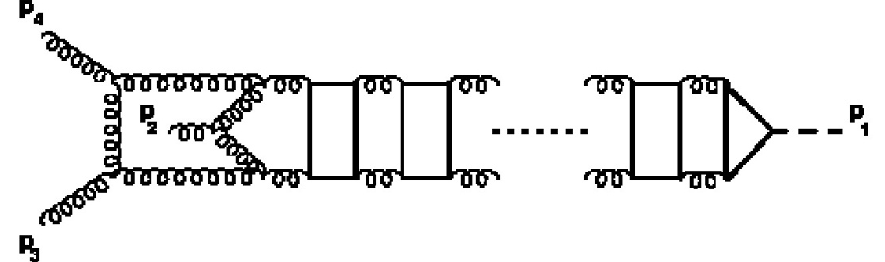
Figure 25. Non-planar box-rocket diagram contributing to H + j